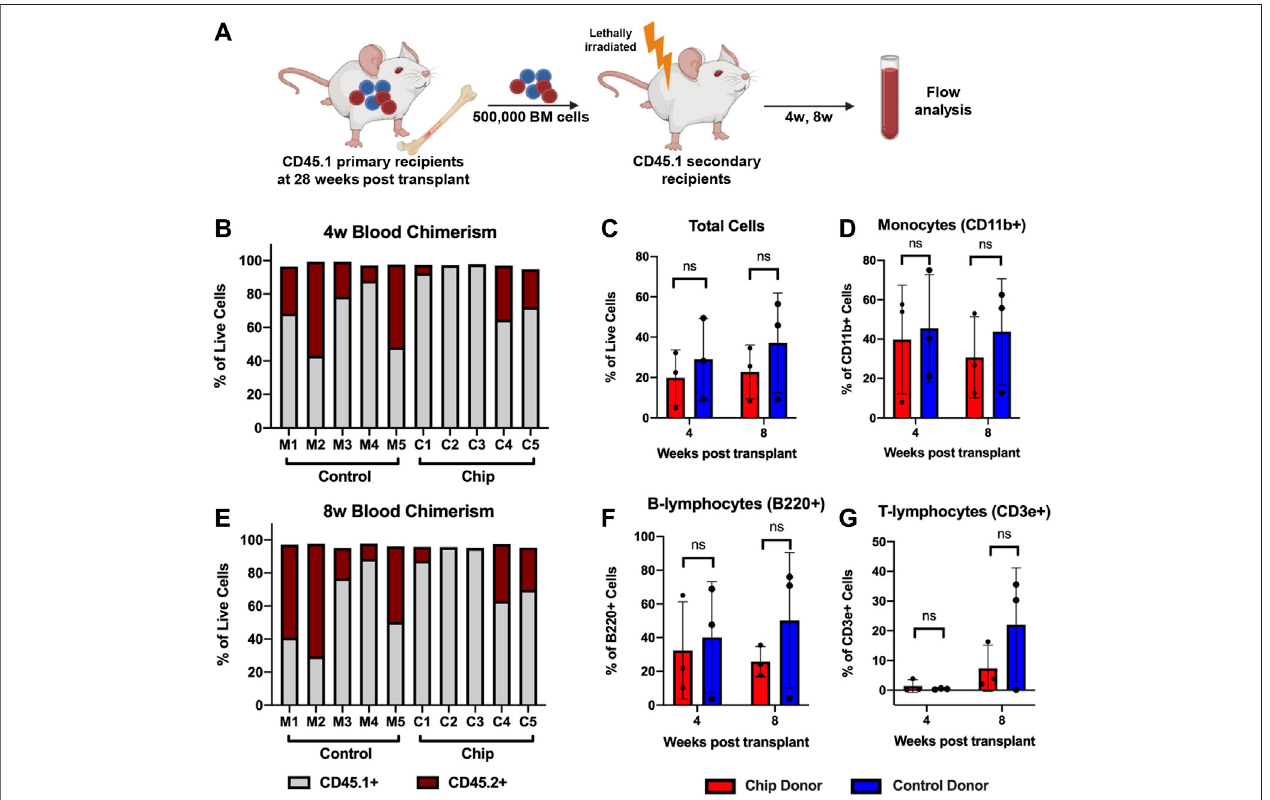
FIGURE 8 | Repopulation of peripheral blood population in secondary transplant recipients shows maintenance of long-term HSPC function after BMME-on-chip culture. (A) Diagramofsecondarytransplantoflethallyirradiatedmicewithbonemarrowcellsfromprimaryrecipientsat28 weekspost-transplant.Peripheralbloodwas analyzed using fl ow cytometry at 4w and 8w post-secondary transplant. (B,C) Flow cytometry data showing chimerism of CD45.2+ donor cells in total live cells in peripheral blood at 4w and 8w. Consistent with bone marrow engraftment data, C2 and C3 do not have CD45.2+ engraftment. (D – F) Flow analysis of total cells, monocytes, and lymphocytes from chip recipients with CD45.2+ engraftment (C1, C4, and C5) compared to mouse recipients (C1, C4, and C5). Flow analyses were performed using FlowJo V10. Statistical analysis for (D – F) was performed using an unpaired t -test. N = 3. ns = non-signi fi cant.